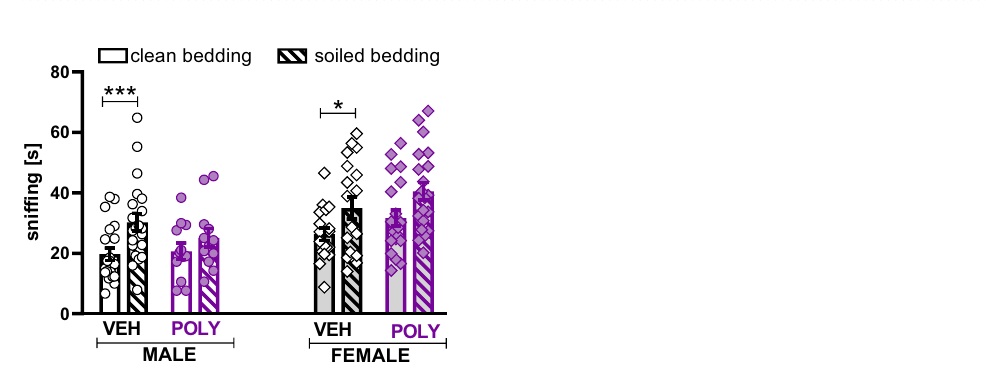
Figure 7. Tickling-induced vocalizations: USV categories. Poly(I:C) exposure increased the number of high frequency modulated (HFM) USVs in females ( a ) but did not change the acoustic characteristics of HFM sounds ( b ). Data are presented as a mean ± SEM of the number of a given call type ( a ) and average duration, bandwidth, and peak frequency ( b ) of the HFM calls. Symbols: ***p < 0.001, a significant difference between vehicle- and poly(I:C)-exposed females (planned comparisons).